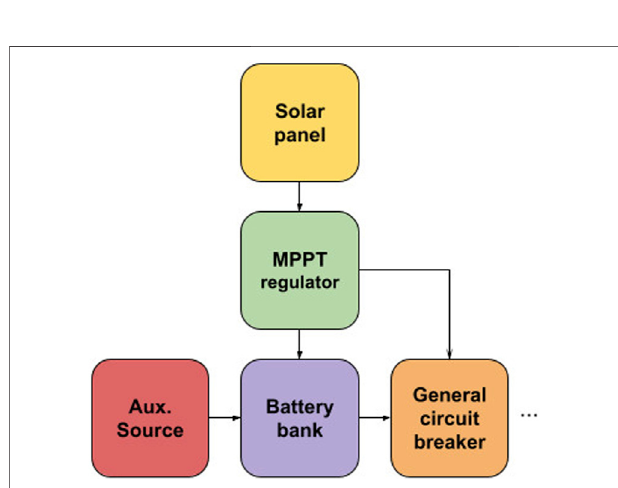
FIGURE 8 | MPPT regulator connected directly to power